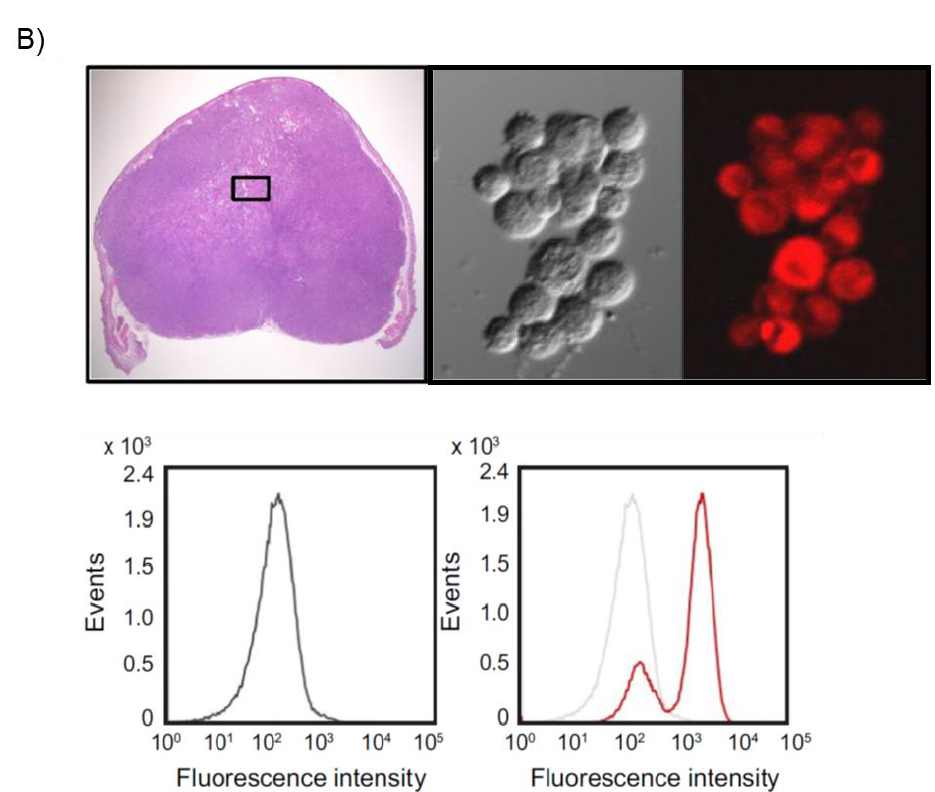
Figure 2. Enhancement of protoporphyrin IX (PpIX)-fluorescence intensity (FI) with an ABC super- family G member 2 (ABCG2) transporter inhibitor Ko143 in human breast cancer cells and xenografts. “Reprinted/adapted with permission from Ref. [26]. 2019, John Wiley & Sons Ltd”. ( A ) Evaluation of PpIX fluorescence in cultured breast cancer cells (MCF7 and MDA-MB-231) and non-cancer cells (MCF10A) after exposure to 5-aminolevulinic acid (5-ALA; 5 mmol/L for 2 h) with or without Ko143 (1 μmol/L). Confocal fluorescence images of PpIX (left panels). Bars: 50 μm. Comparison of mean FI of PpIX (right panel). All error bars represent the SD ( n = 3). * p < 0.05. ( B ) Fluorescent analysis of fine needle aspiration (FNA) samples obtained from human breast cancer xenografts of MDA-MB-231 cells in nude mice. A hematoxylin and eosin image of a subcutaneous xenograft is shown (upper left panel). Differential interference contrast (upper middle panel) and PpIX fluorescence (upper right panel; excitation: 440 nm, emission: 615 – 645 nm) images of MDA-MB-231 cells collected through FNA after incubation with 5- ALA (5 mmol/L for 2 h) and Ko143 (1 μmol/L). Flow cytometry analyses of the cells with (lower right panel) and without (lower left panel) incubation with 5-ALA and Ko143 are shown. The black and red lines denote the control nontreatment group and the group treated with 5-ALA and Ko143, respectively. The horizontal axis shows PpIX inten- sity.